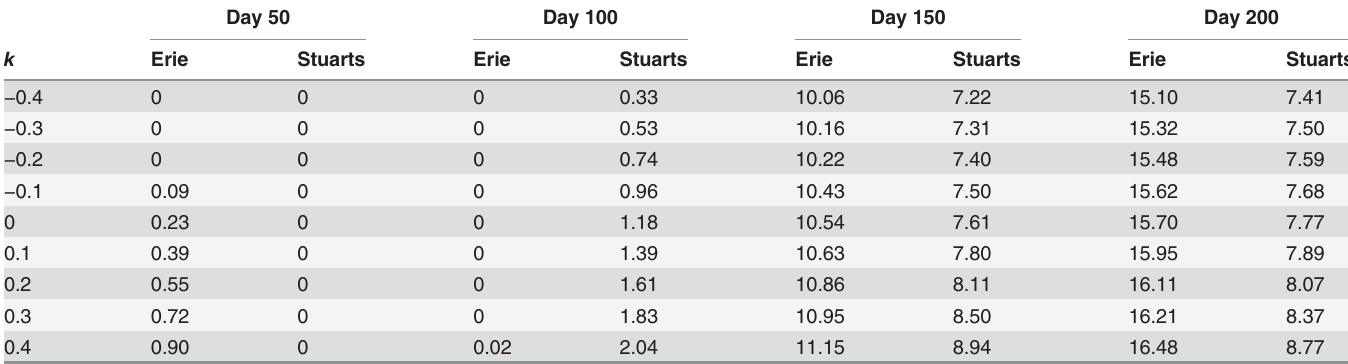
Note: Stuarts stands for Stuart Draft, VA, in the table. At a given day and location, it is almost consistent that larger DTR (larger k value) is related to more degree-day accumulation, even when the mean temperature remains the same. For non-leap years, day 50 is Feb 19, day 100 is Apr 10, day 150 is May 30, and day 200 is Jul